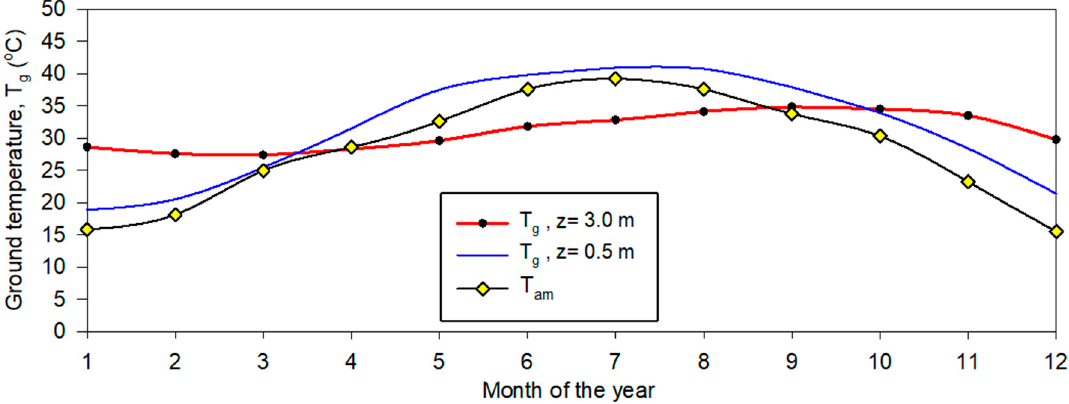
Figure 4. Vertical variation in the monthly average ground temperature ( T g ) at different depths ( z )